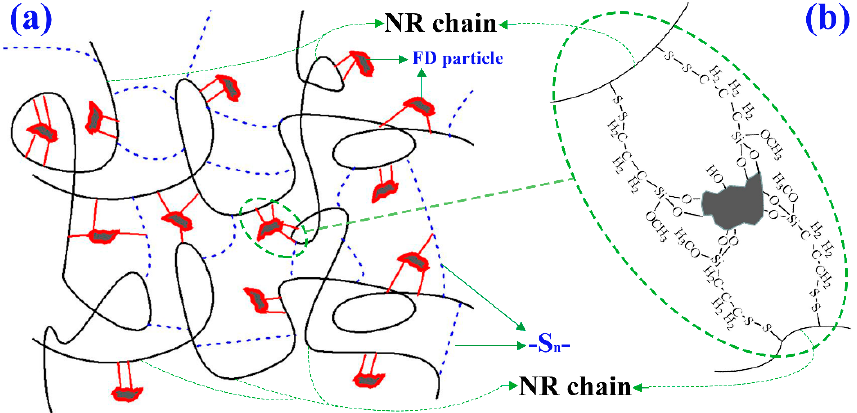
Figure 8. Schematic diagram of the interfacial interaction between mFD and natural rubber. ( a ) FD particles modified with Si 69 uniformly dispersed in the cross-linked natural rubber phase. ( b ) chemical bonds formed between FD surface and NR chains. Natural rubber macromolecular chains are represented by the long black irregular curves; natural rubber macromolecular chains are cross-linked by -S n - [-S n -: single sulfur bond (n = 1); double sulfur bond (n = 2) and multi sulfur bond (n > 2), is represented by the short blue dotted line]; FD particles is represented by the gray irregular polygon; the surface modified Si 69 on FD particles is represented by the red closed curve; the chemical bonds between the surface of FD particles and NR chains is represented by the short red line.